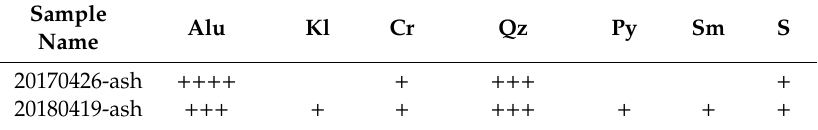
Table 2. Relative intensities of hydrothermal minerals by the XRD